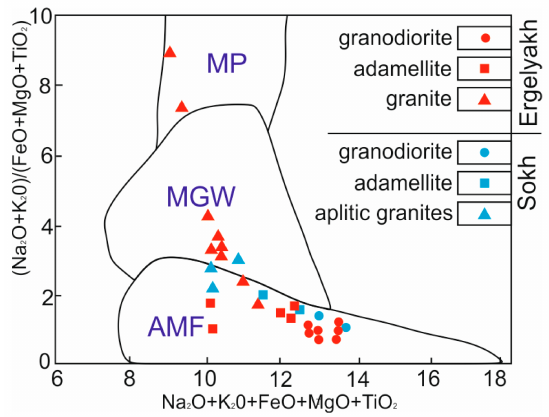
Figure 8. (Na 2 O + K 2 O) / (FeO + MgO + TiO 2 ) – (Na 2 O + K 2 O + FeOT + MgO + TiO 2 ) diagram for EIRGD granitoids [54]. MP, metapelites; MGW, metagraywackes; AMF, amphibolites.